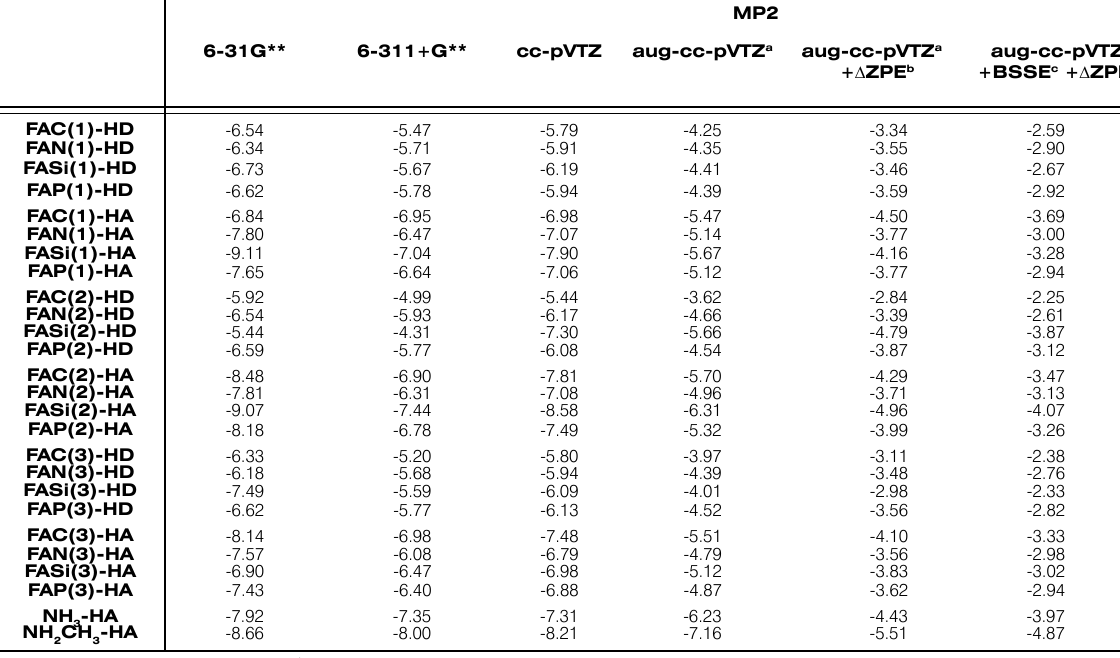
Table 2. H-bond energies (in kcal mol -1 ) calculated at MP2 level with various basis sets.